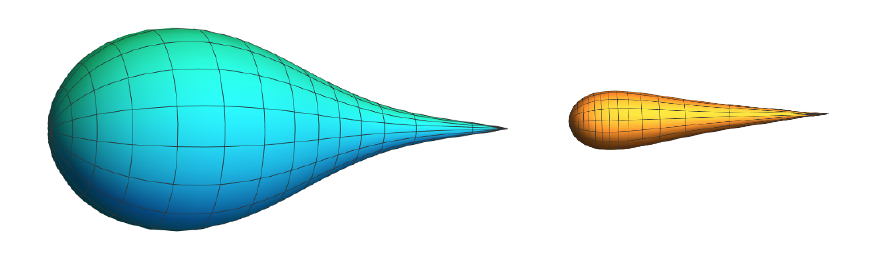
Figure 22 . Embedding in Euclidean space of the boundary (left) and the horizon (right) of a \bottle shaped" black hole of region D2 (cid:22) = 13, (cid:23) = 7 : 23, close to the border with D4: (cid:23) = 2